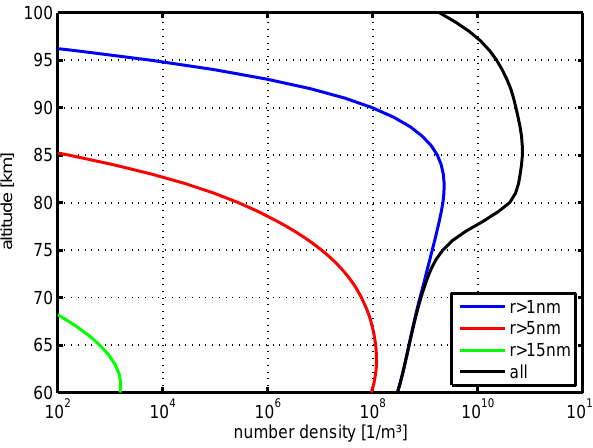
Fig. 5. Sum of MSP number densities for particle sizes greater than 1 nm (blue), 5 nm (red) and 15 nm (green) and all MSP (black), from the model of Megner et al. (2006).